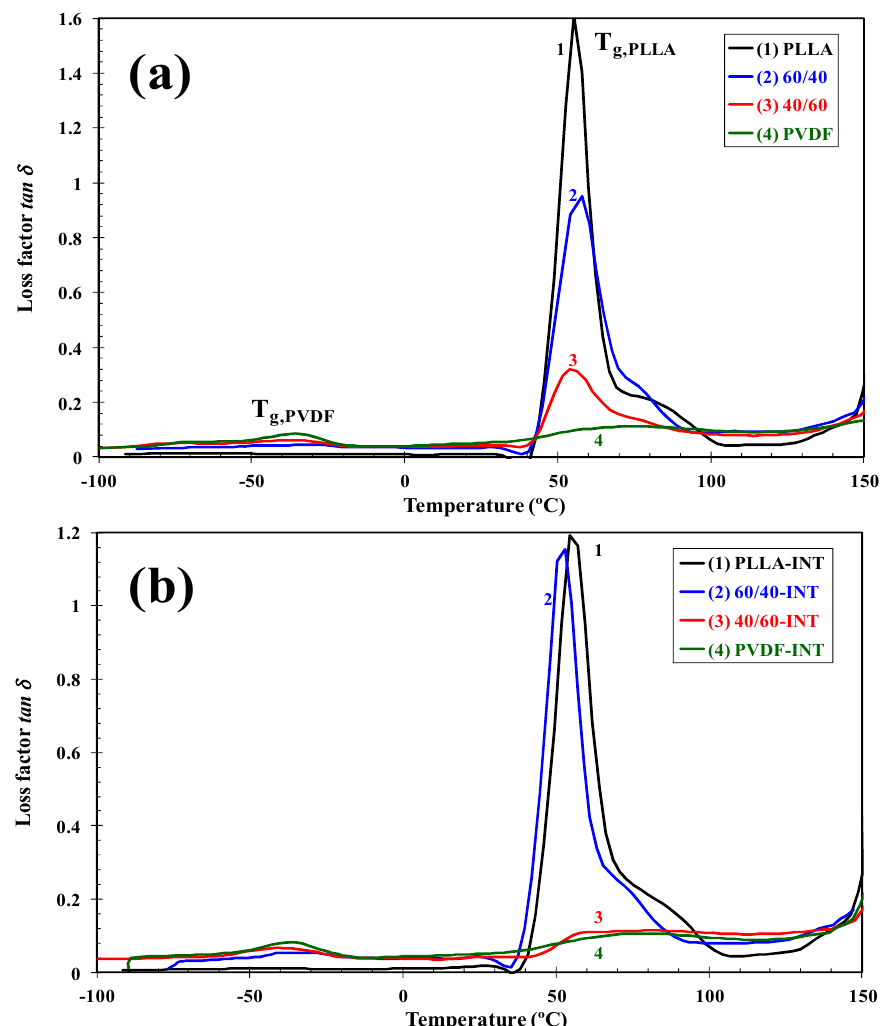
Figure 12. Evolution of the loss factor ( tan δ ) as a function of temperature for indicated ( a ) binary PLLA/PVDF and ( b ) ternary PLLA/PVDF/INT-WS 2 hybrid nanocomposites obtained in the tensile mode at 1 Hz.